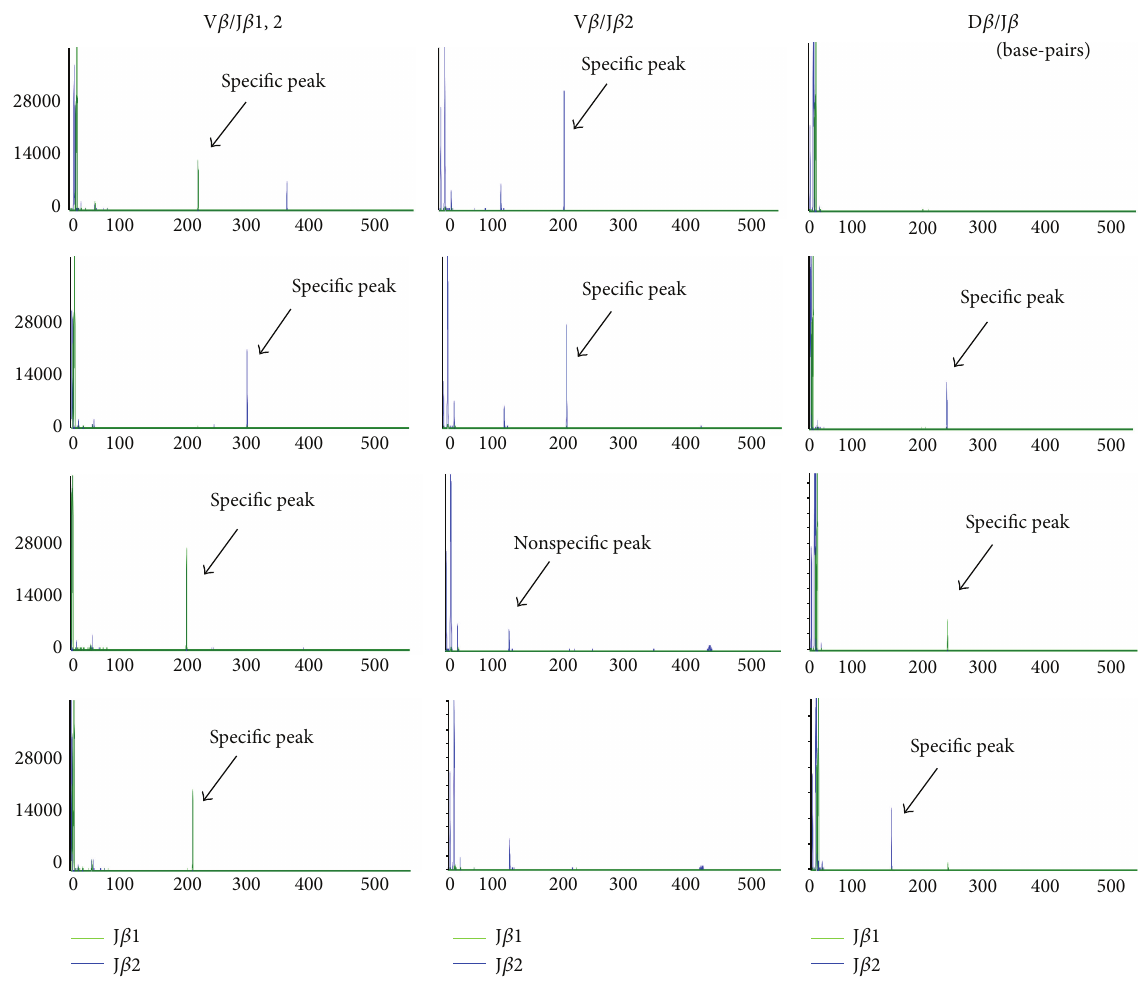
Figure 3: A wide variety of TCR- 𝛽 gene arrangement patterns in TIL-iPSCs. Characterization of the TCR- 𝛽 gene arrangement in TIL-iPSCs from patients (A) and (B) by capillary electrophoresis. The green line is derived from the band for the J 𝛽 1 gene, and blue line is derived from the band for the J 𝛽 2